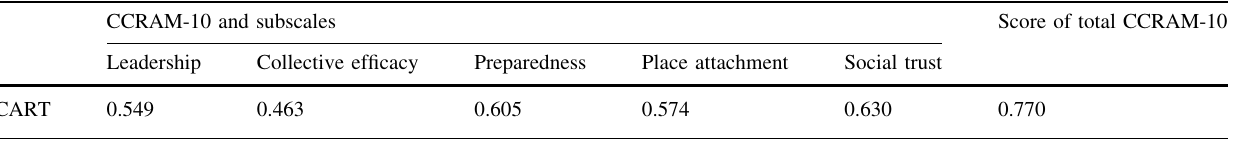
Table 4 Convergent validation between the Communities Advancing Resilience Toolkit (CART) Assessment Survey and the Chinese Version of the10-item Conjoint Community Resilience Assessment